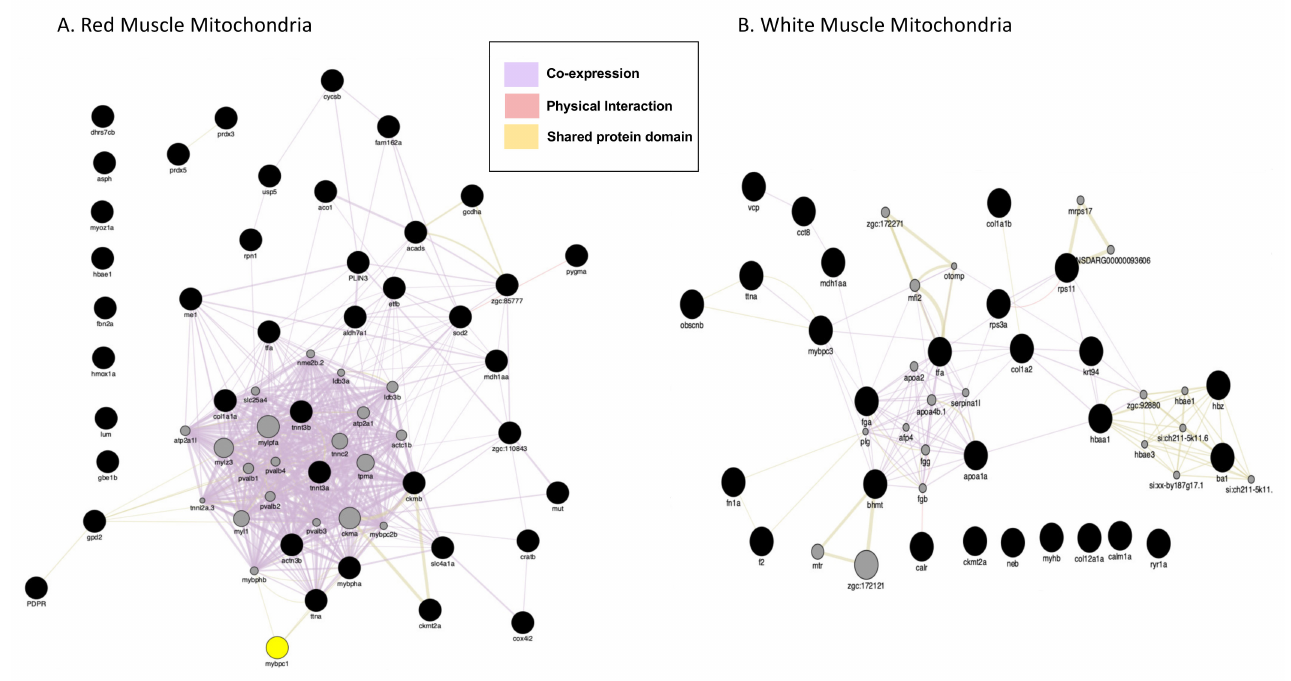
Figure 4. Gene interaction network for proteins with lower abundance in icefish ( A ) RMM and ( B ) WMM. ( A ) GeneMANIA gene–gene interaction network for protein abundance following the pattern N. rossii (+/+), T. bernacchii (+/+), C. rastrospinosus ( − /+) and C. gunnari ( − / − ) in decreasing order of their protein abundance, laid out and visualised with Cytoscape, showing interaction strength (edge thickness), interaction type (colour-bottom right), multiple edges between nodes, protein score (node size) Black dots indicate query proteins, and grey dots depict neighbouring